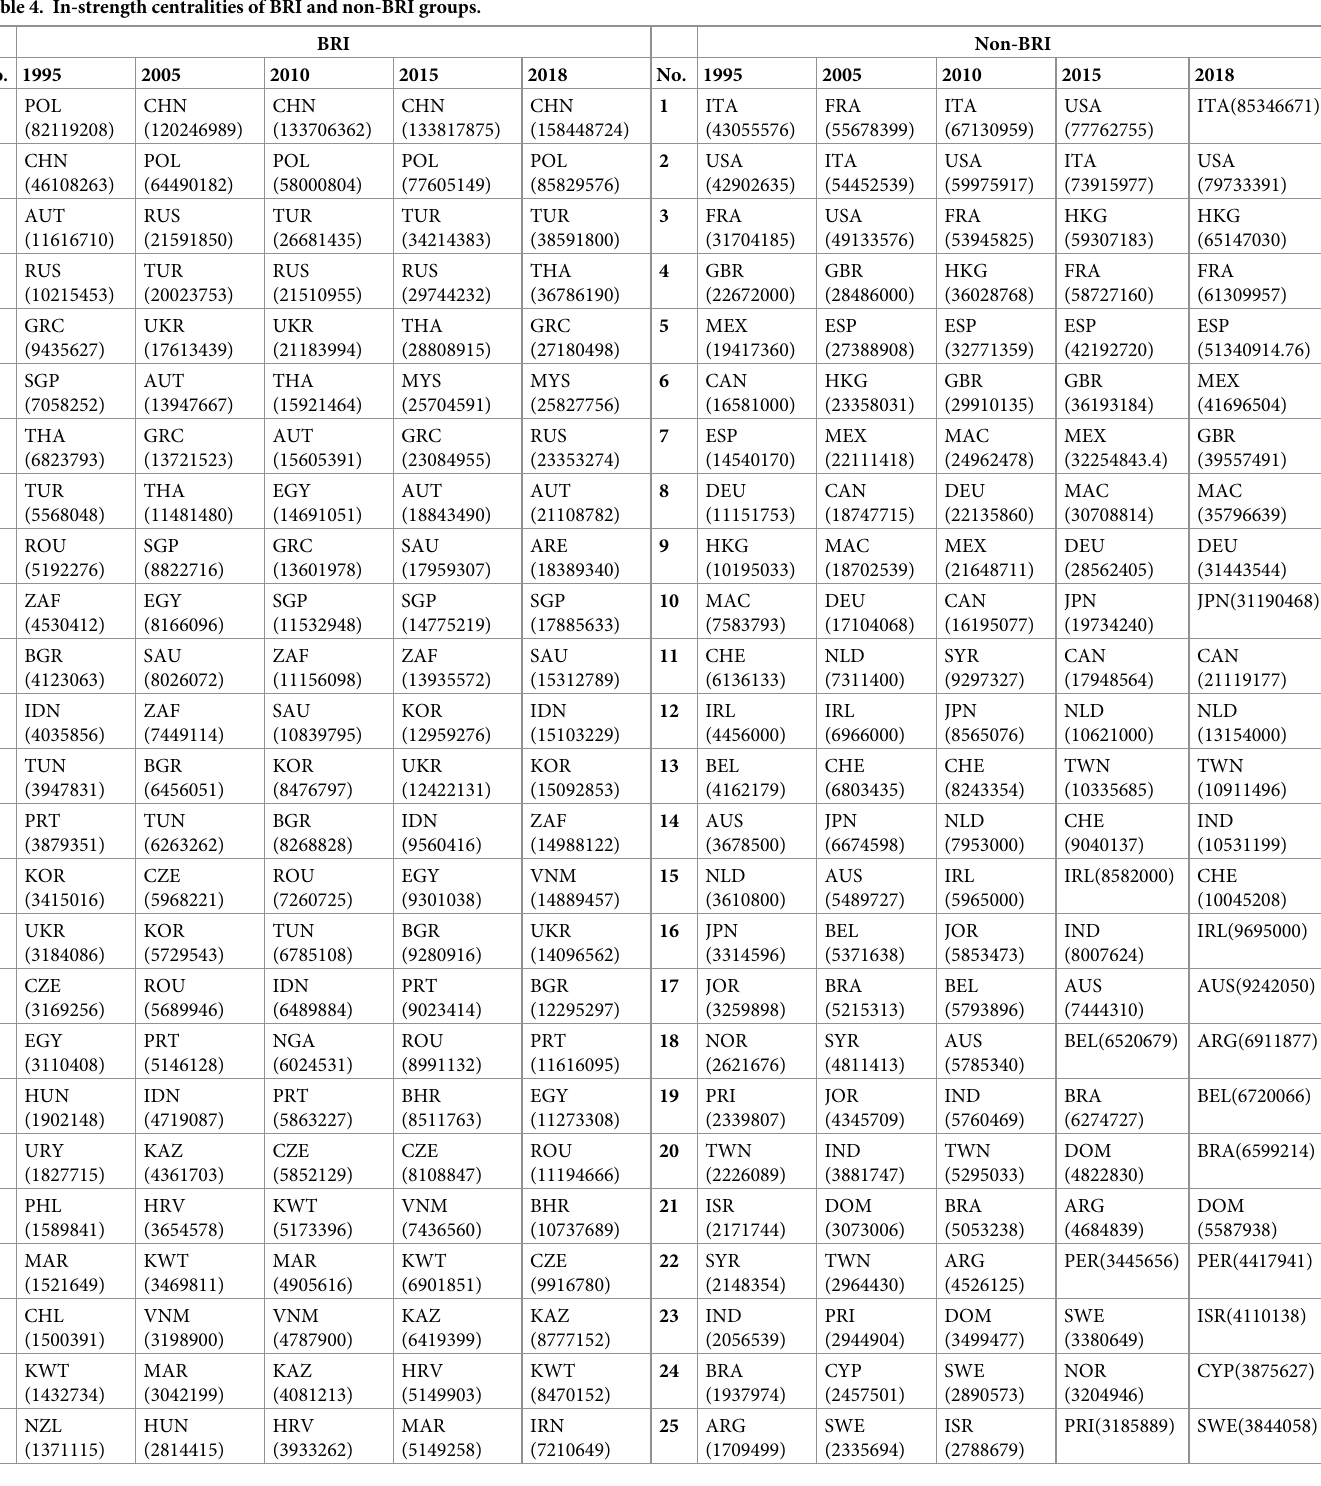
Table 4. In-strength centralities of BRI and non-BRI groups.